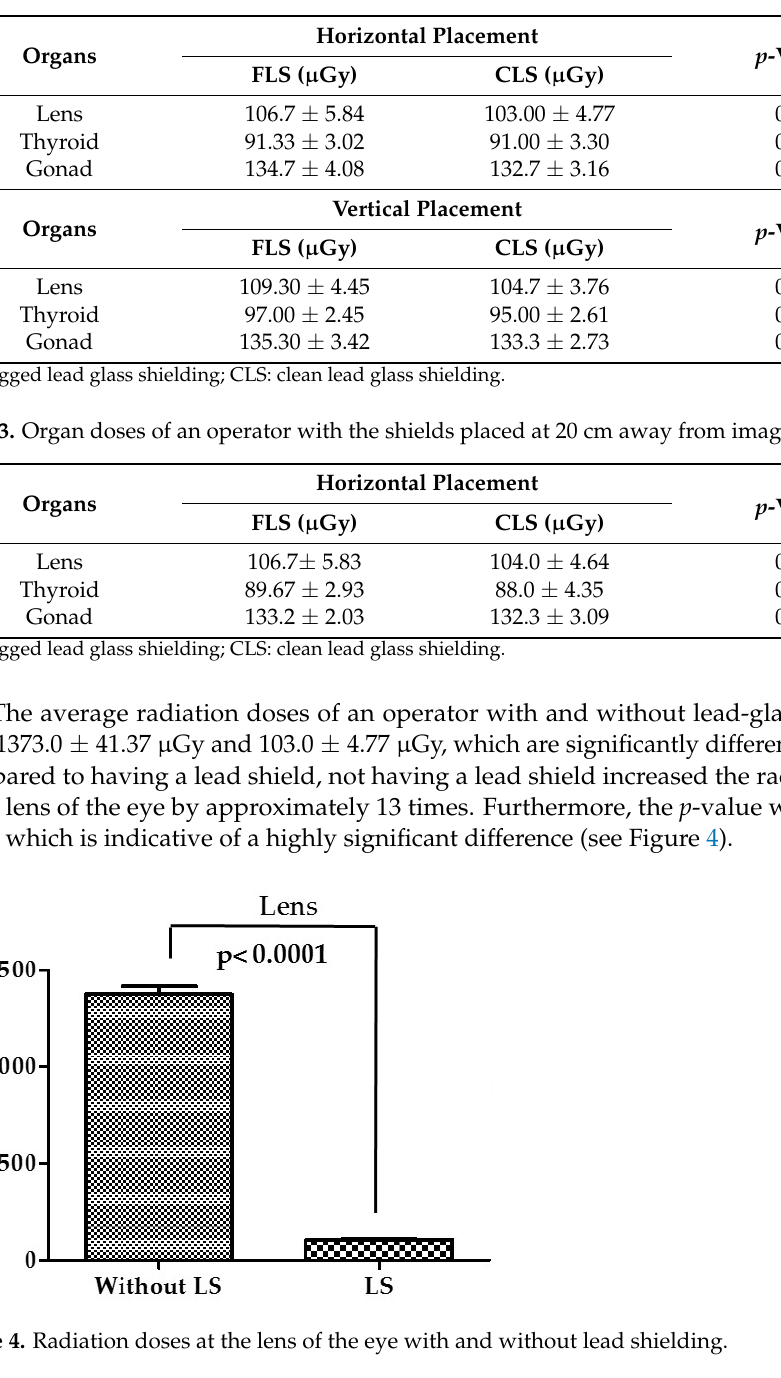
p -Value p -Value